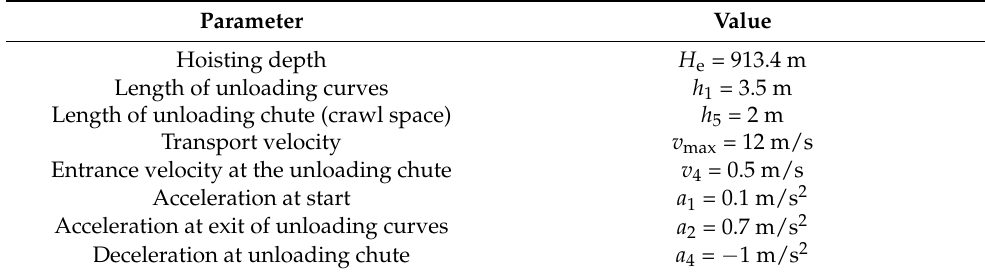
Figure 4. Characteristic six-phase hoisting diagram of the MK5 × 2 type hoisting installation. Table 2. Hoisting parameters of the studied MK5 × 2 hoisting installation